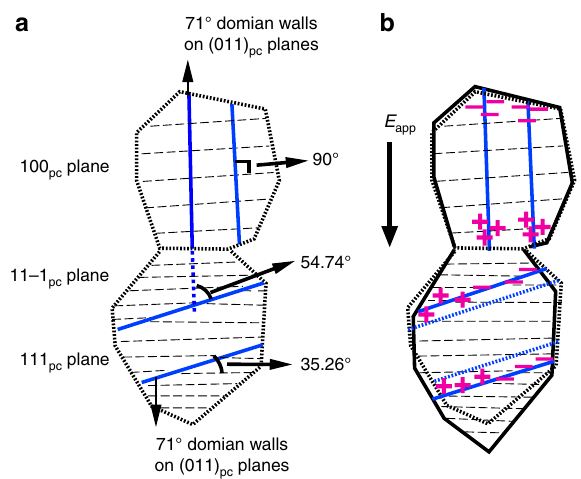
Fig. 4 Schematic of two representative grains in poled BiFeO 3 . a The diffraction planes and orientations of 71° domain walls, occurring on (011) pc planes, in {100} pc and {111} pc grains. In {100} pc grain (top grain), the 71° domain wall (solid blue lines) is perpendicular to the 100 pc diffracting planes (black dashed line). In the {111} pc grain, the 71° domain walls separate 111 pc and 11 (cid:1) 1 pc diffracting planes and form an angle of 35.26°. The angle between 71° domain walls in {100} pc and {111} pc grains is 54.74°; b charge distribution on conductive domain walls under applied external electric fi eld, E app = E 0 sin( ω t ). Charge redistribution rate is different for grains with different crystallographic orientations, i.e., {100} pc and {111} pc . Their dielectric permittivities, electrical conductivities and piezoelectric coef fi cients are thus different, represented by κ 100 and κ 111 , σ 100 and σ 111 , and d d fi elds in 100 and 111 , respectively. This will result in different effective individual grains, represented by E 100 and E 111 . The grain elongations upon fi eld application, indicated by the solid black shapes, are due to the piezoelectric effect in the {100} pc grain and non-180° domain wall motion in the {111} pc